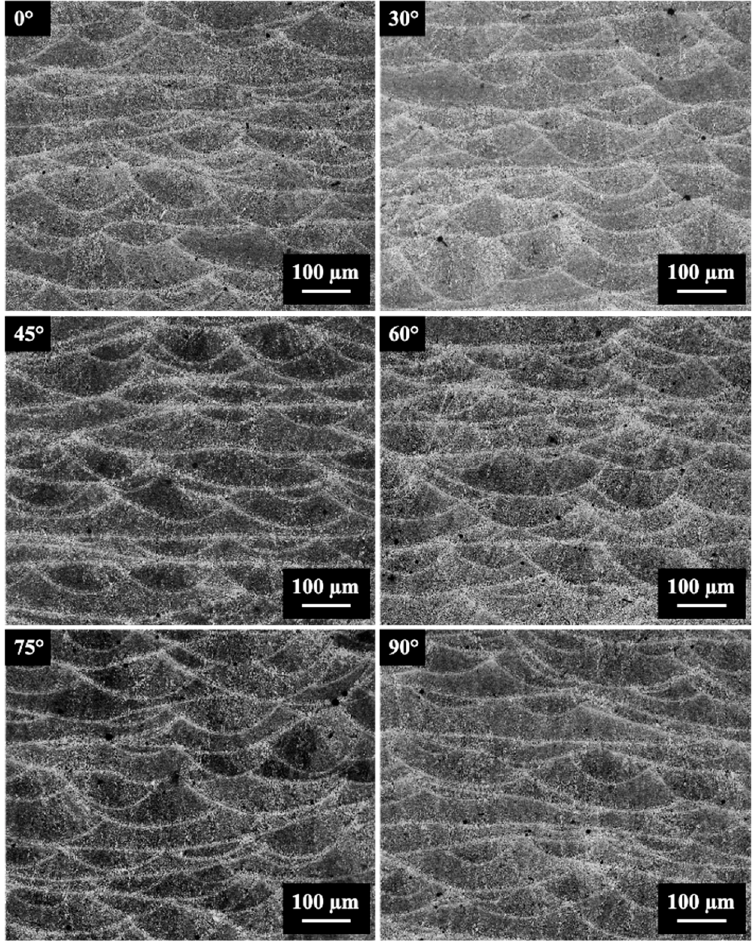
Figure 10. Optical macrographs of the thin L-PBF parts, taken along the build direction (100× mag- Figure 10. OpticalmacrographsofthethinL-PBFparts, takenalongthebuilddirection(100 × nification).